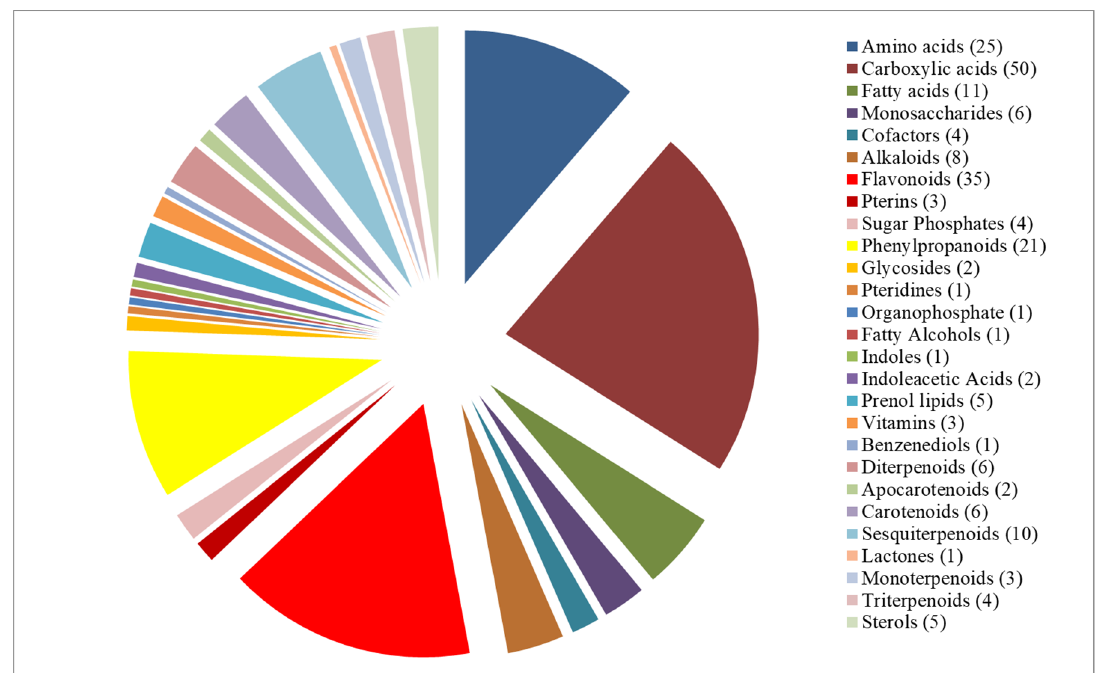
Figure 2. Classification of 221 sorghum grain metabolites into metabolite classes. Number in parentheses indicates number of metabolites mapped against each class.